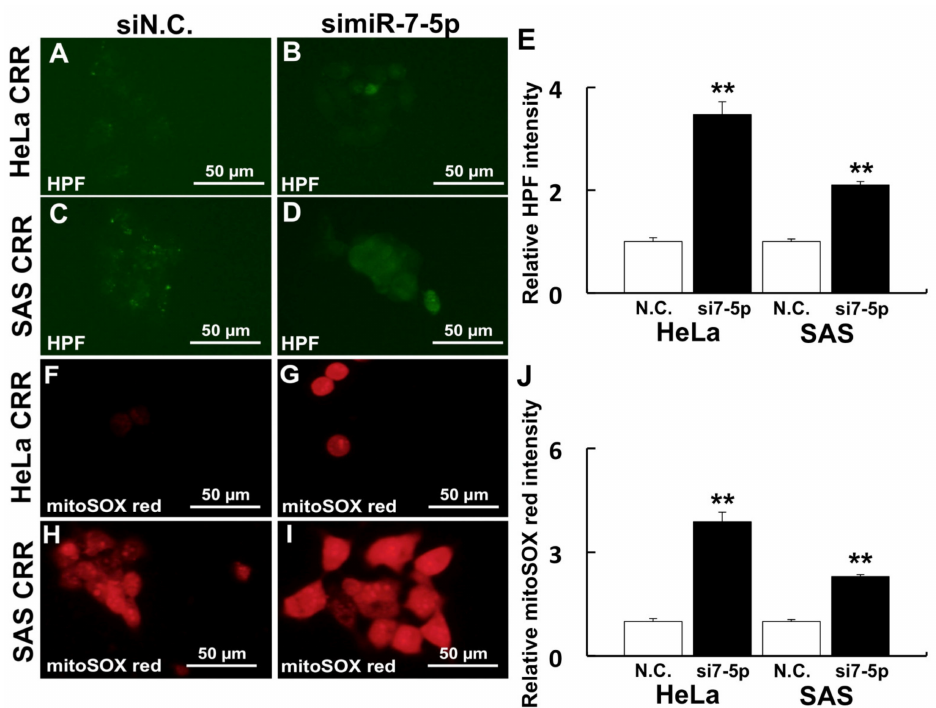
Figure 1. Knockdown of miR-7-5p increased ROS in CRR cells. Cells were treated with 10 µ M HPF and 5 µ M mitoSOX TM red to detect • OH and mitochondrial superoxide (O 2 •− ) after a miR-7-5p knockdown, respectively. HPF is a fluorescent probe, which detects hydroxyl radical in cells and mitoSOX TM red is a reagent that emits red fluorescence by reacting with mitochondrial superoxide. ( A – E ) Intracellular • OH visualized by HPF. ( F – J ) Mitochondrial O 2 •− visualized by mitoSOX TM red. ( A , F ) HeLa CRR cells siN.C. treatment. ( B , G ) HeLa CRR cells simiR-7-5p treatment. ( C , H ) SAS CRR cells siN.C. treatment. ( D , I ) SAS CRR cell simiR-7-5p treatment. ( E ) Relative HPF intensity (HeLa CRR N.C.: n = 60, HeLa CRR simiR-7-5p: n = 30, SAS CRR N.C.: n = 32, SAS CRR simiR-7-5p: n = 78). ( J ) Relative mitoSOX TM red intensity (HeLa CRR N.C.: n = 30, HeLa CRR simiR-7-5p: n = 11, SAS CRR N.C.: n = 77, SAS CRR simiR-7-5p: n = 31). **: p < 0.01 using Student’s t test. Knockdown of miR-7-5p significantly increased ROS.